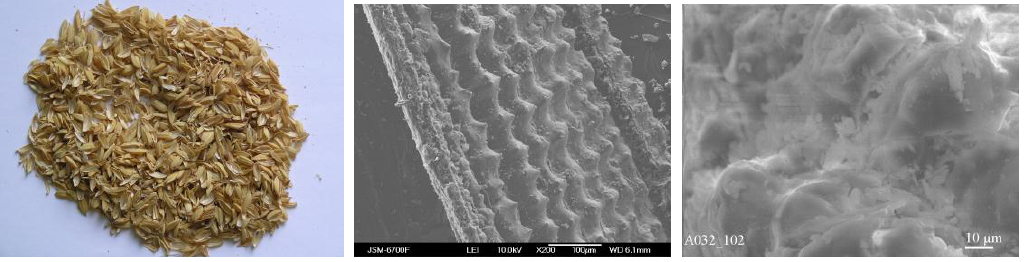
Figure 1. Original rice husk images